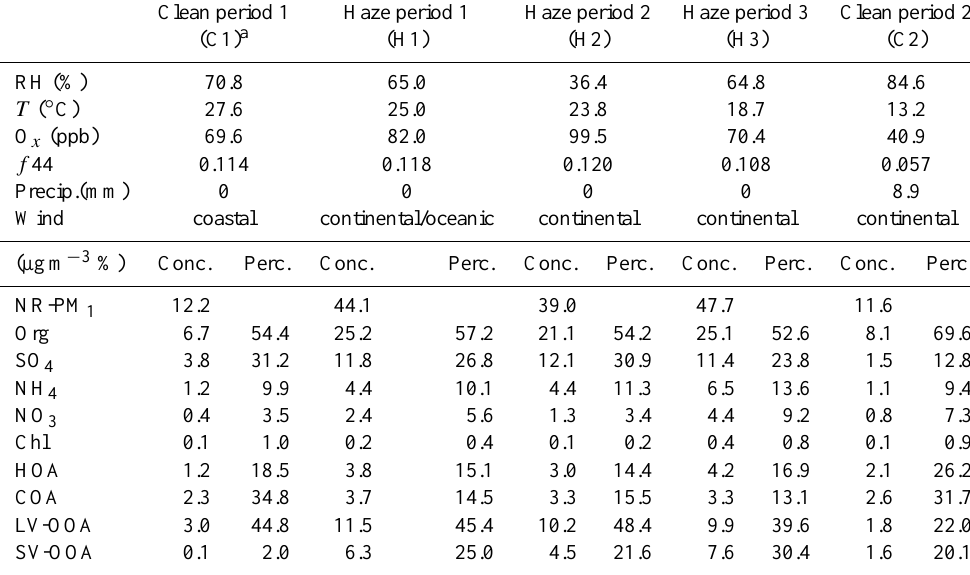
Table 4. Measured and calculated parameters in five chosen periods (C1, H1, H2, H3 and